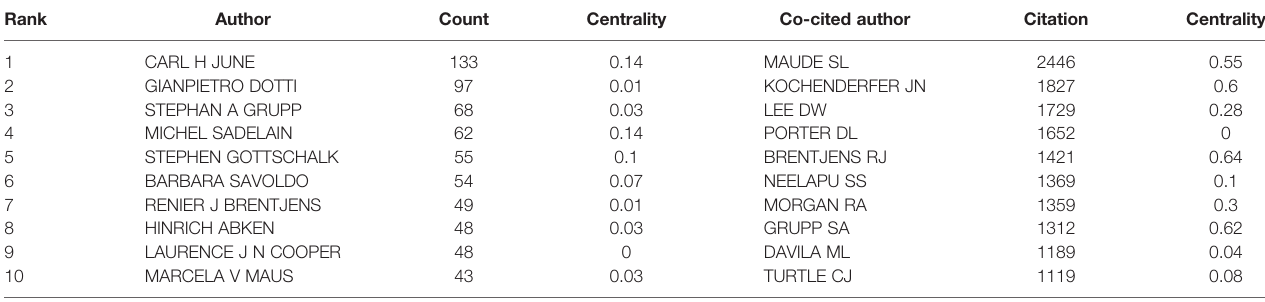
TABLE 3 | The top 10 authors and co-cited authors of CAR-T cell research.